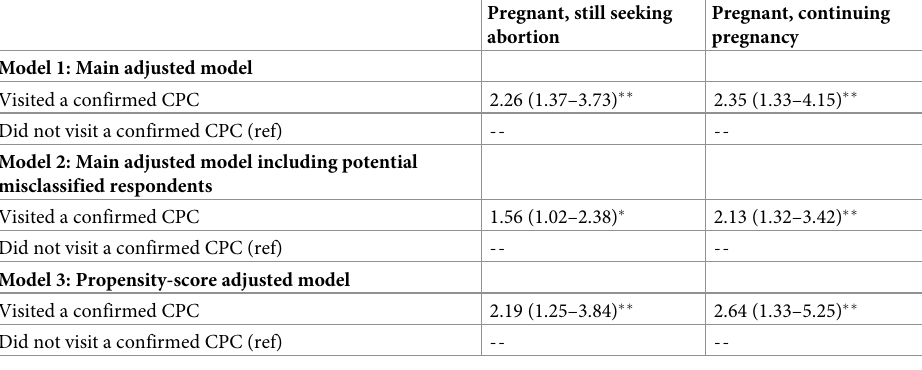
Table 3. Adjusted odds ratios from mixed effects logistic regression models assessing associations between visit- ing a confirmed CPC and being pregnant and seeking abortion or continuing pregnancy compared to having had an abortion at 4-week follow-up (N =